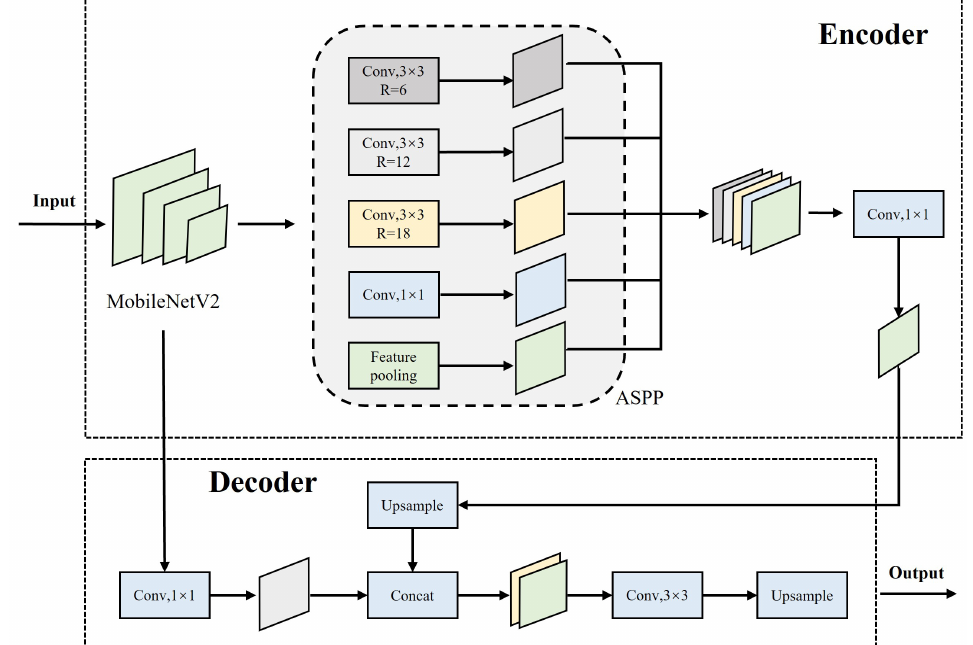
Figure 3. The network model of